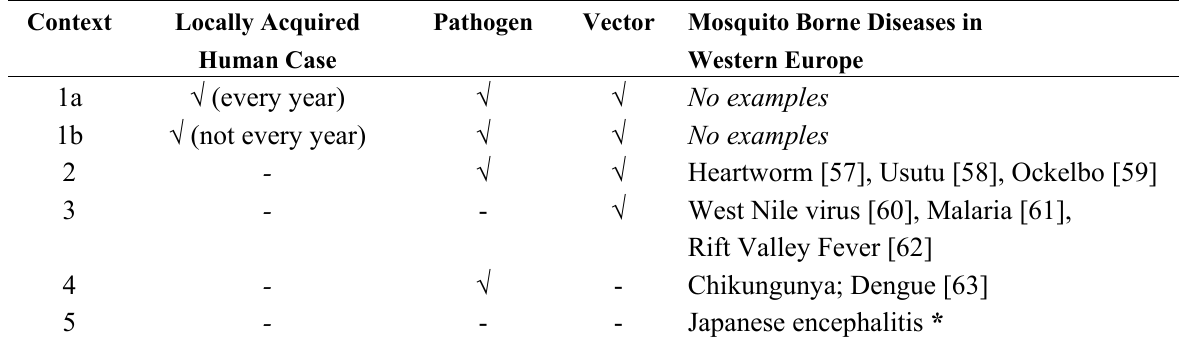
Table 2. Current situations of mosquito borne diseases for Western Europe, here delimited by Belgium, Netherlands and UK